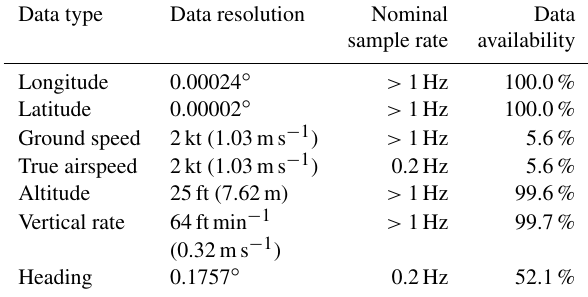
Table 1. Parameters and basic characteristics of the KNMI data used in this paper. Nominal reporting frequency is based on whether the parameter is ADS-B or Mode-S EHS content. Data availability is a percent of all aircraft reports where the parameter was success- fully received and decoded.